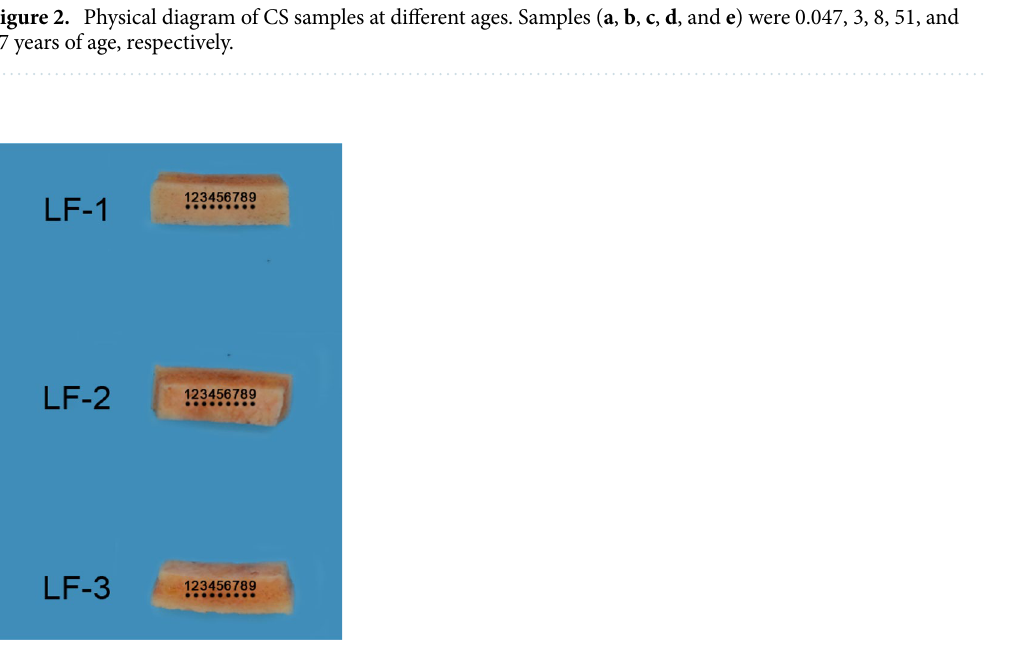
Figure 3. Bitmap of nanoindentation points of inner plate, diploe and outer plate of the